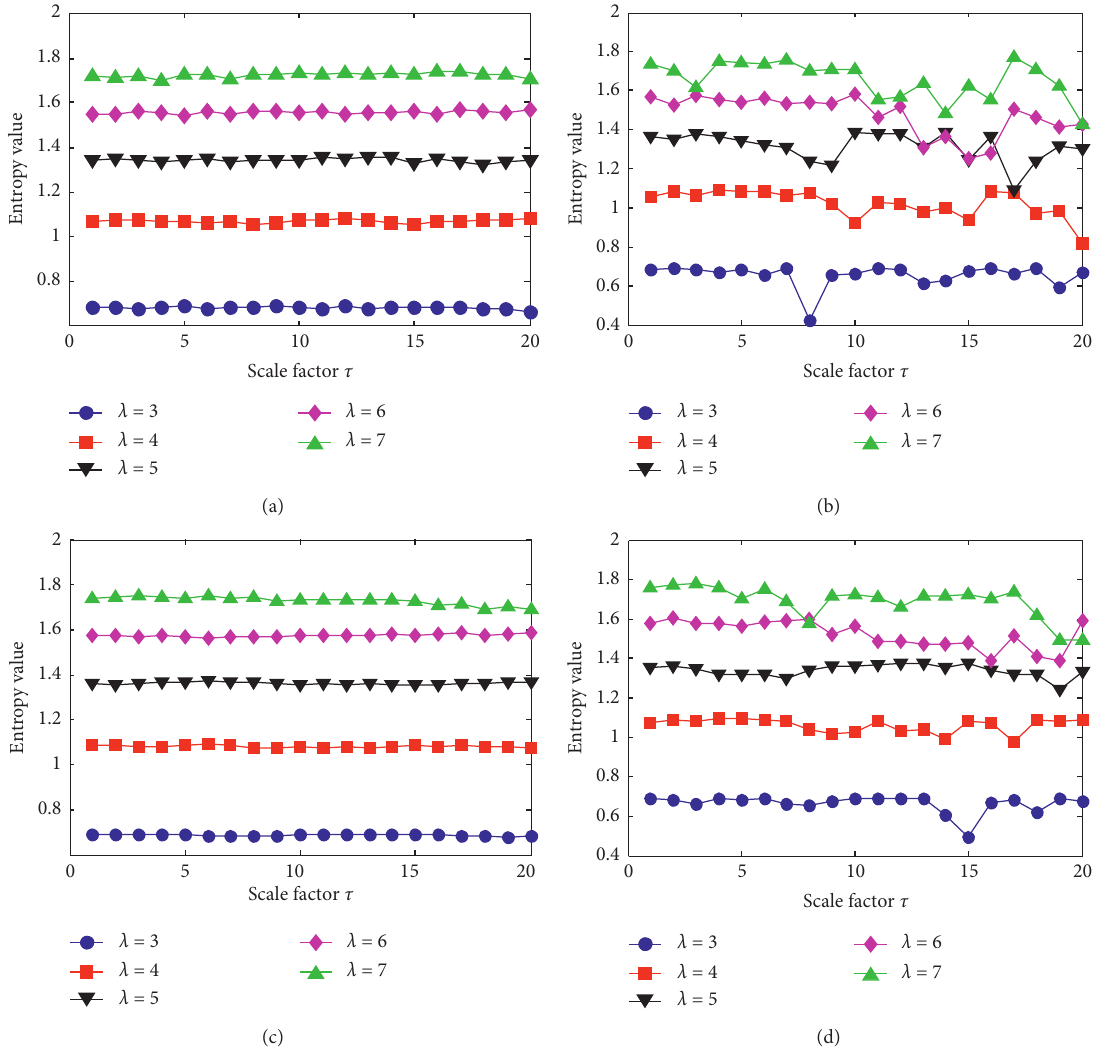
Figure 10: MPGSE and MPSE of the noise signal under different SE scales. (a) MPGSE of white noise, (b) MPSE of white noise, (c) MPGSE of 1/ f noise, and (d) MPSE of 1/ f